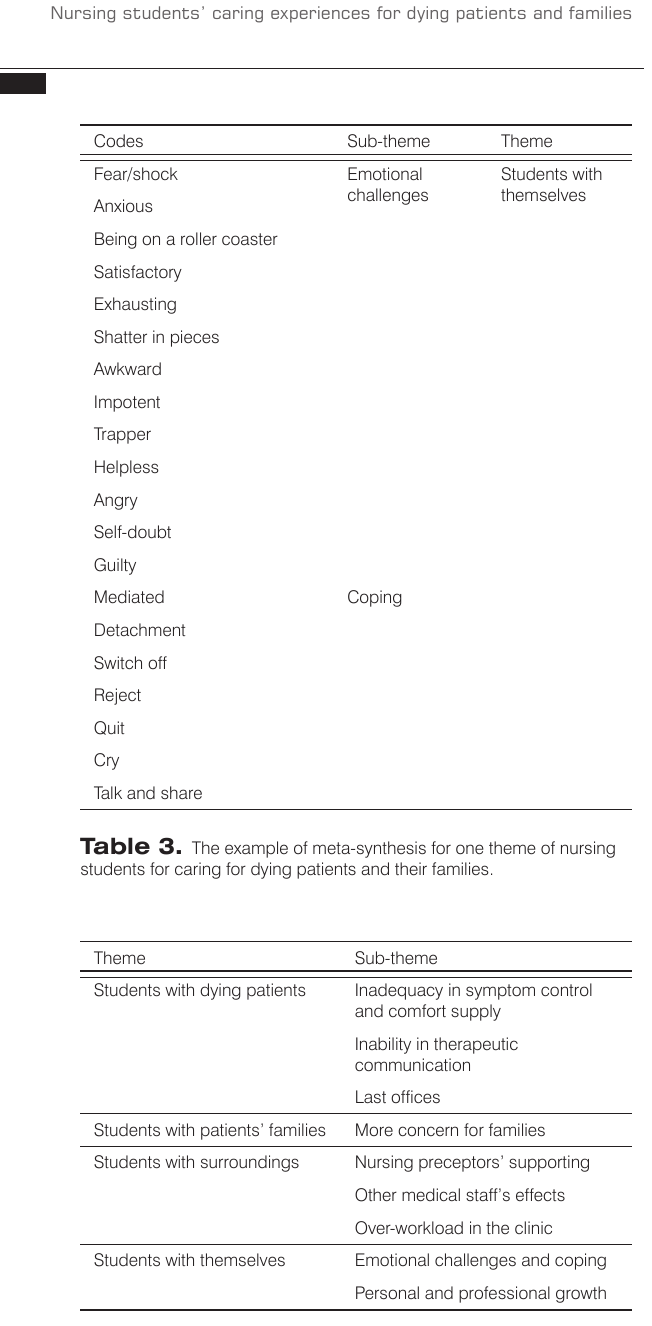
Table 4. Themes and sub-themes on the